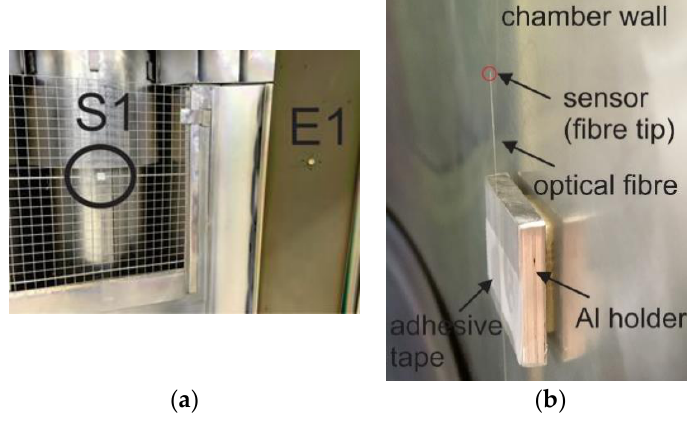
Figure 2. ( a ) Fixation of the sensor S1 and ( b ) the photo of a sensor